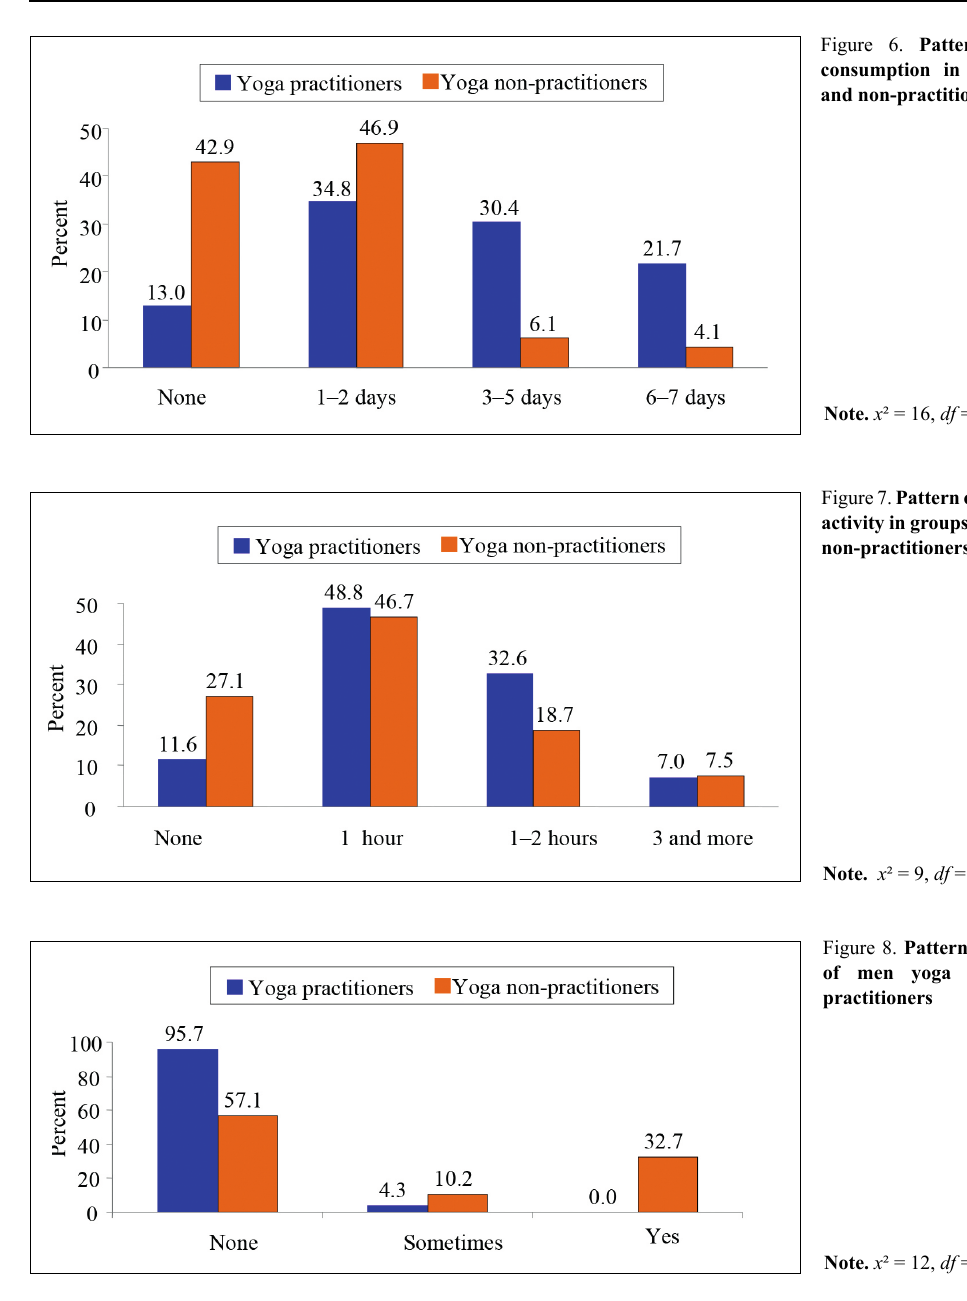
Note. x ² = 12, df = 2, p <